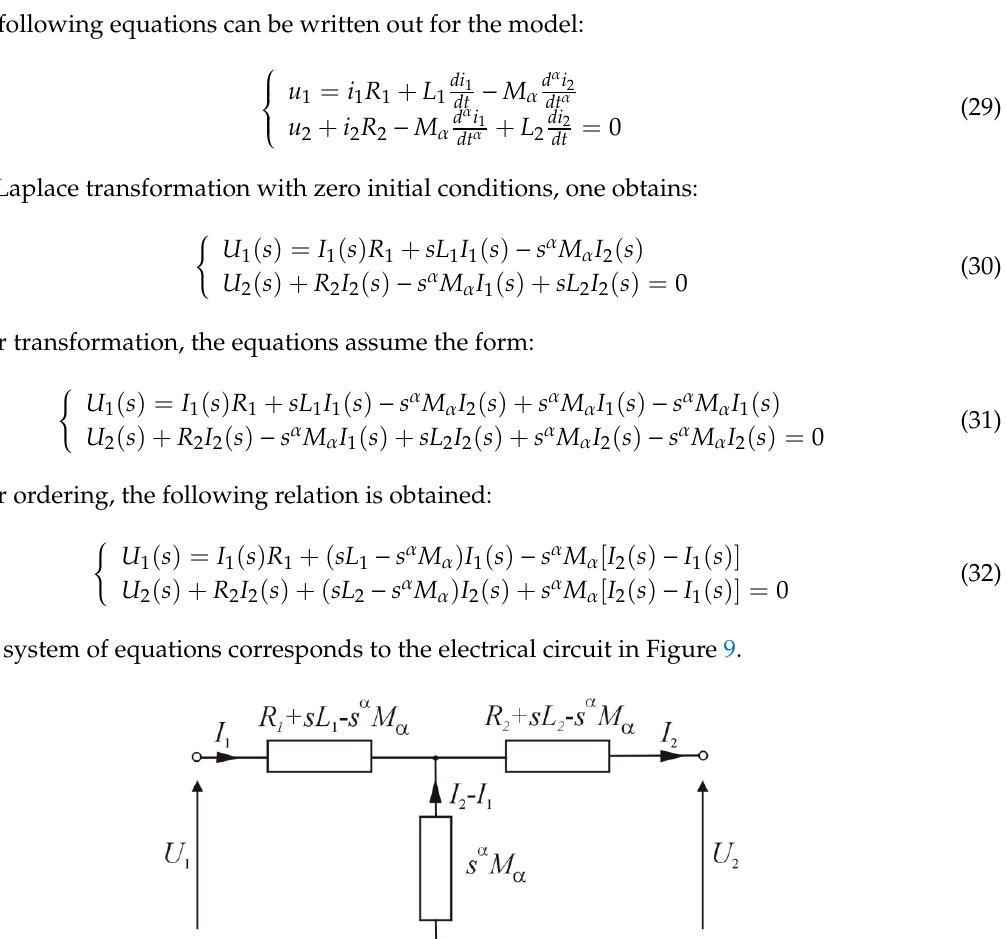
Figure 8. Circuit model with fractional-order magnetic coupling.